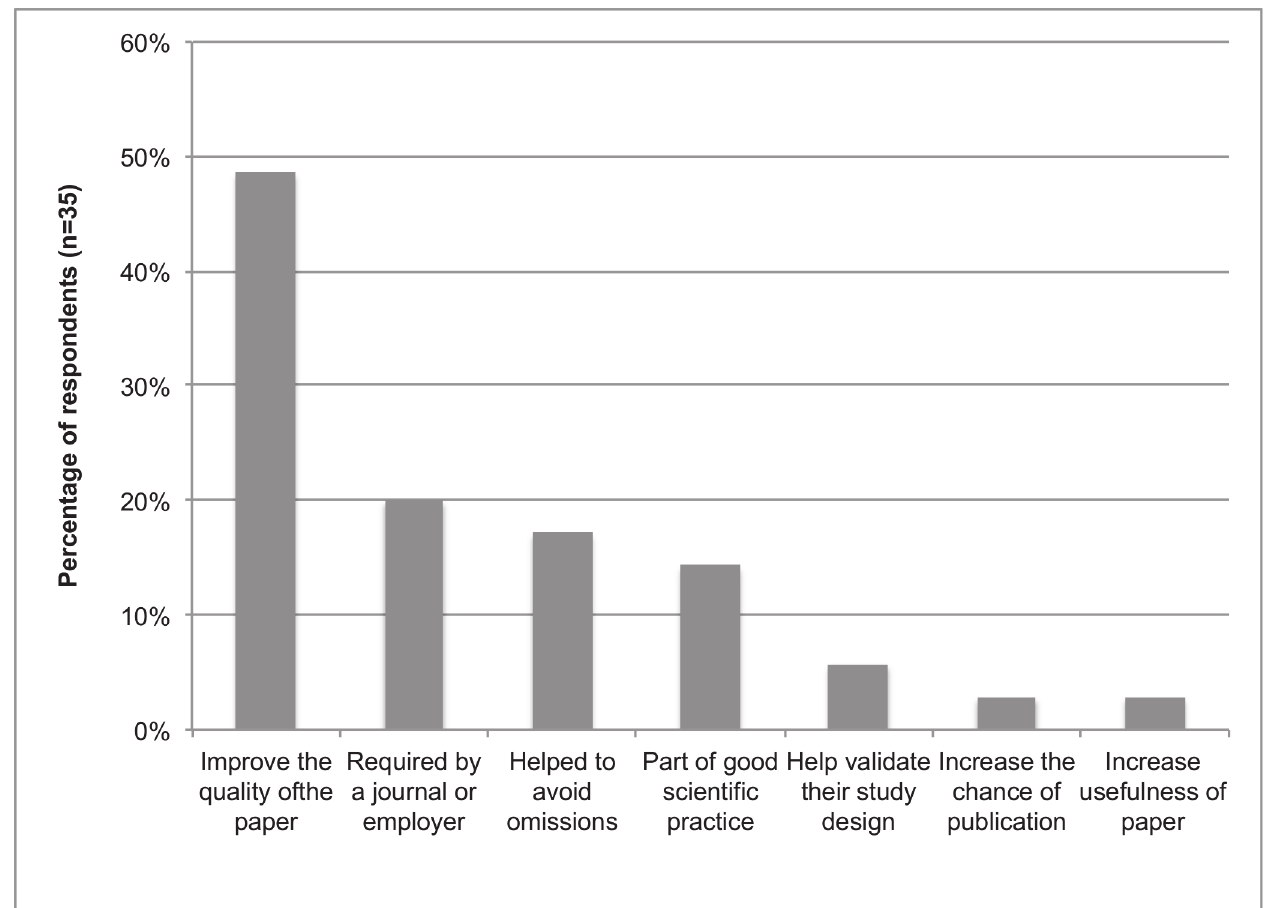
Fig 5. Authors ’ reasons for using reporting